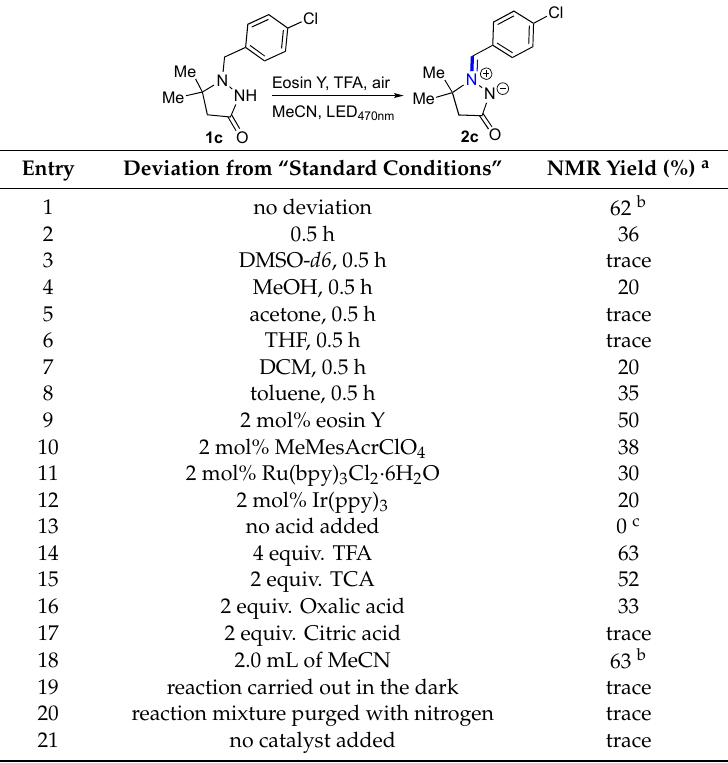
Table 1. Deviation from the standard reaction conditions for the transformation of pyrazolidine-3-one 1c to azomethine imine 2c